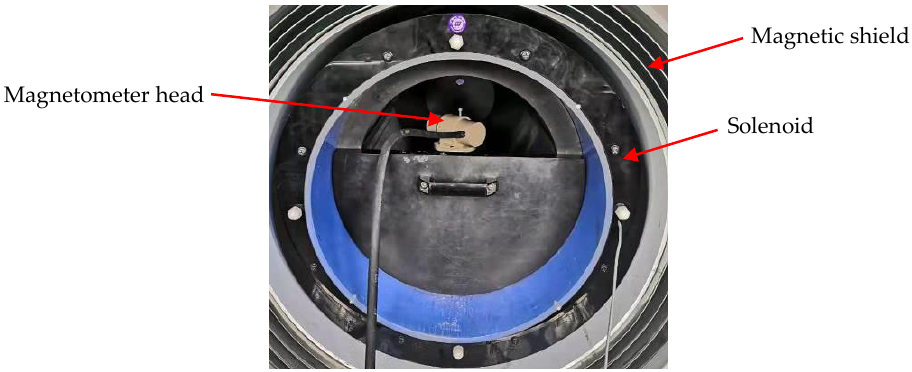
Figure 8. Photo of the experimental set-up.